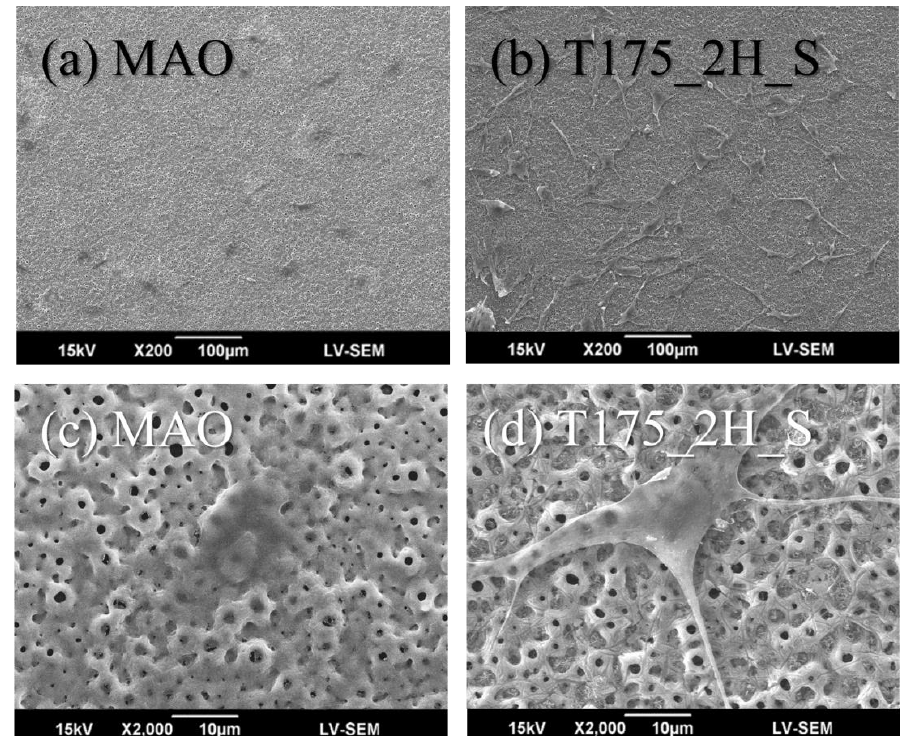
Figure 7. The MC3T3-E1cell morphology after 24 hours of adhesion upon ( a ) MAO coatings and ( b ) the hierarchical structures fabricated using hydrothermal treatment at 175 °C for 2 hours (sample T175_2H_S). ( c ) and ( d ) were the enlarged images of ( a ) and ( b ).